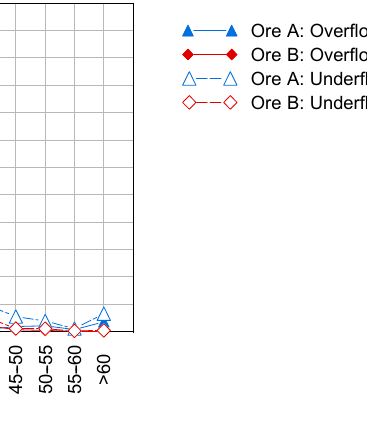
Figure 10. Distribution of particle shape at the DMS cut-point.